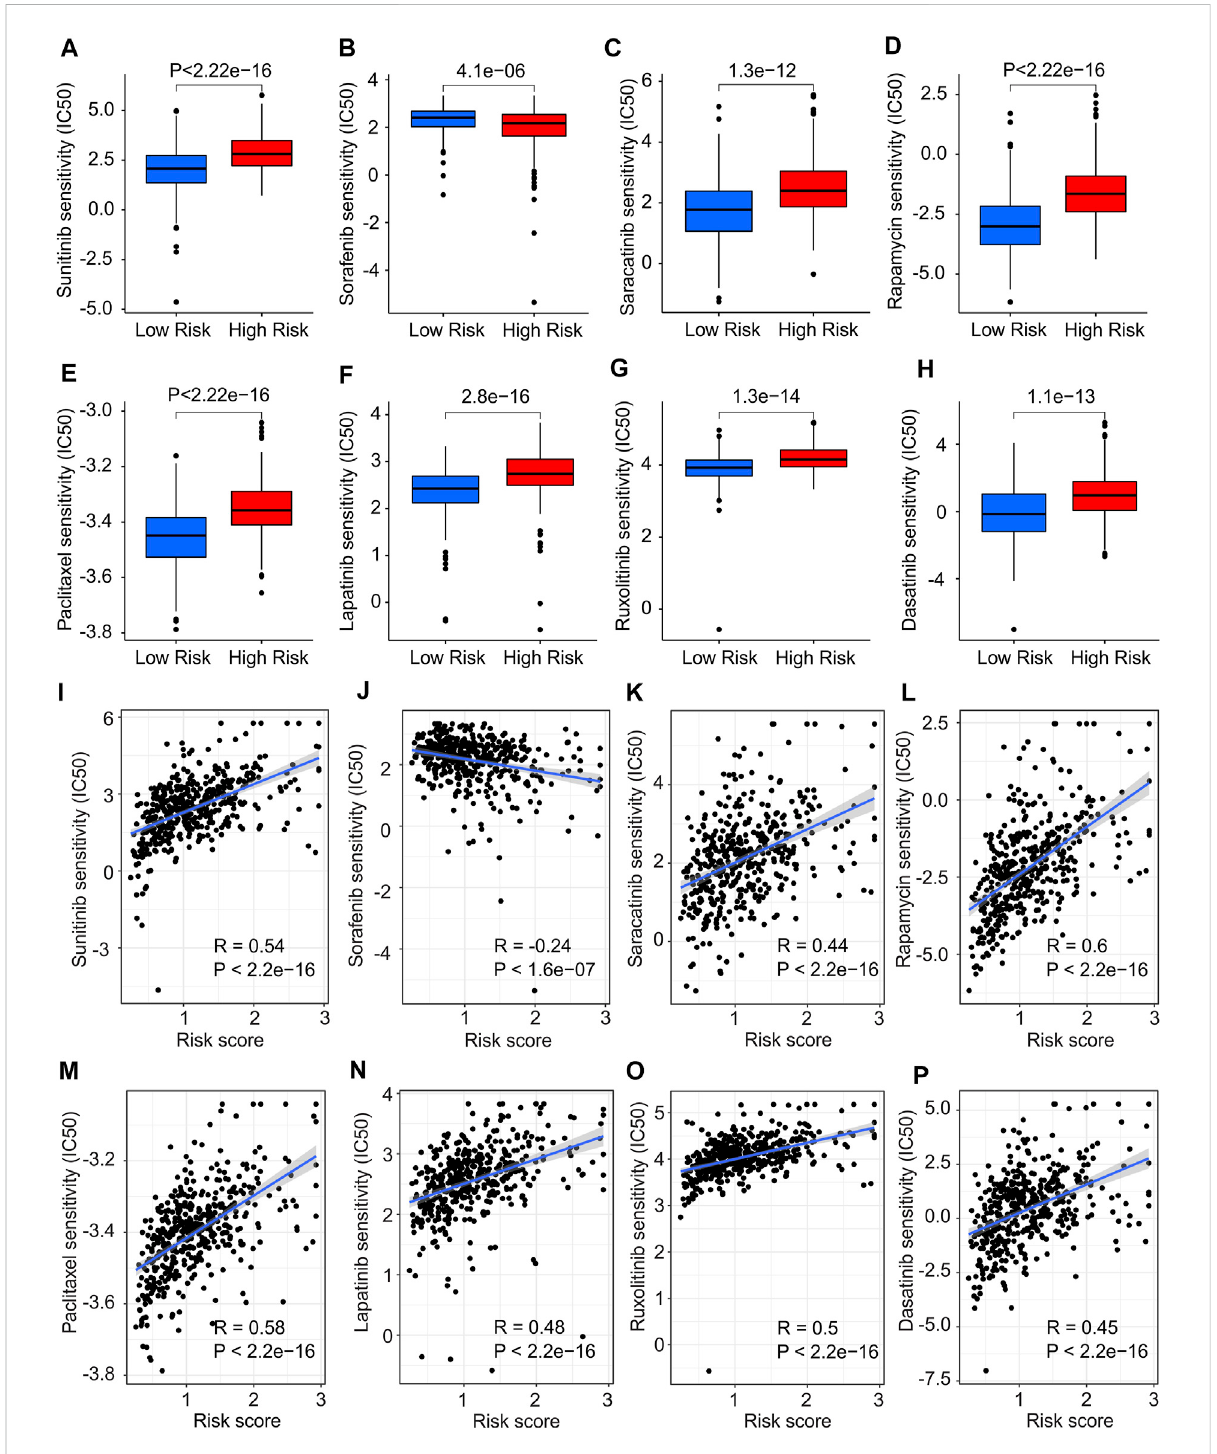
FIGURE 11 Drug sensitivity analysis in low- and high-risk group. The IC50 value exhibits a signi fi cant difference in low- and high-risk group among (A) Sunitinib, (B) Sorafenib, (C) Saracatinib, (D) Rapamycin, (E) Paclitaxel, (F) Lapatinib, (G) Ruxolitinib and (H) Dasatinib. (I – P) Correlation analysis of risk score and drug